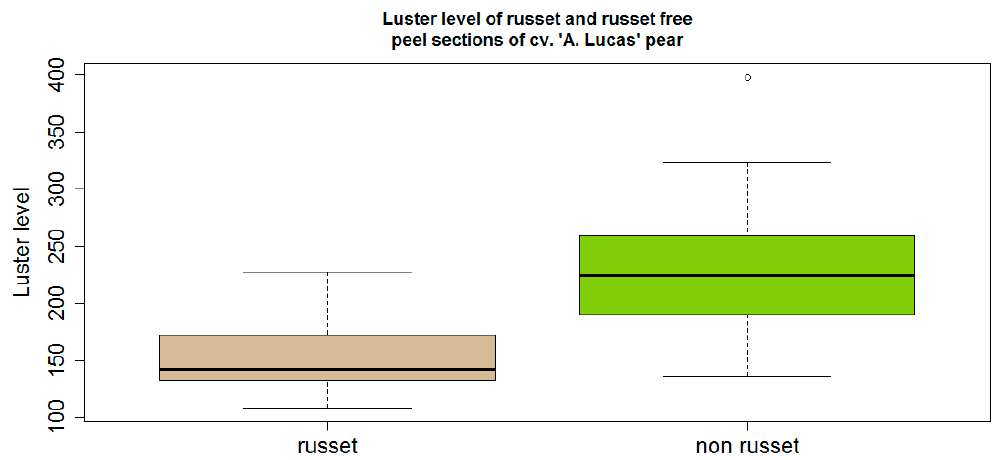
Figure 4. Significantly different luster level of russeted versus russet-devoid green peel sections of cv. “Alexander Lucas” (statistics: p = 3.3 × 10 − 8 << α = 0.05; n = 18).